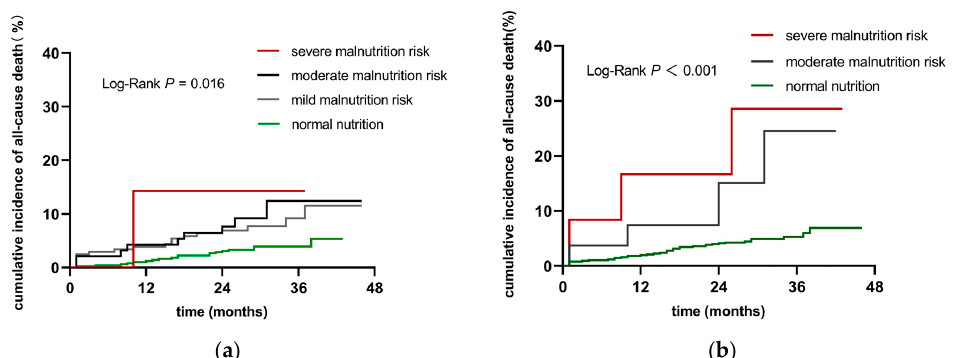
Figure 1. Comparison of cumulative incidence of all-cause death during follow-up ( a ) Cumulative incidence of all-cause death stratified by the GNRI; ( b ) Cumulative incidence of all-cause death stratified by the PNI.